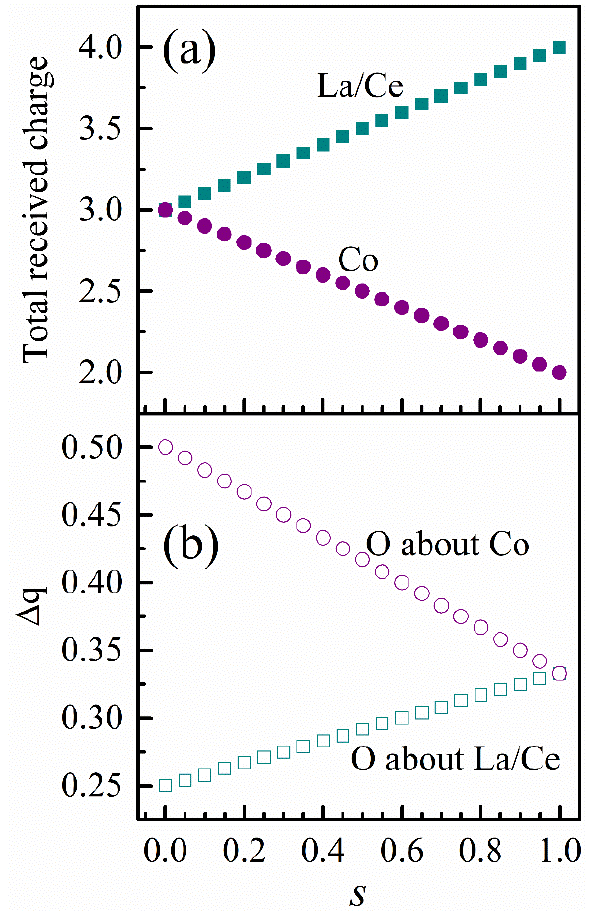
Figure 4. ( a ) Total charge received by La/Ce and Co and ( b ) fraction of charge ( △ q) received by each O-coordination about La/Ce and Co as a function of s , the fraction of cerium dopants in La 1 − s Ce s CoO 3 , which is the main phase of La 1 − x Ce x CoO 3 . The calculations use the structural param- eters obtained from the Rietveld refinement analysis, considering the main lattice as a cubic lattice. Figure 6 shows XANES data at the La L 3 -edge for La 1 − x Ce x CoO 3 . The spectrum of the pristine LCO reveals a sharp white line and two post-edge bulging features. These structures indicate holes in the La 5 d -band, O 2 p -La 5 d hybridization states, and possibly part of EXASF, respectively. It is clearly visible that the white line becomes enhanced with increasing Ce content, whereas the post-edge structure analogous to the bulge in the middle of the x = 0 spectrum takes a flat shape in the cases x = 0.2 and x = 0.4. These changes establish direct evidence that the La 5 d -band of the pristine LCO is in a partially filled state and eventually turns into a less occupied state when subject to the Ce addition. This finding on the occupancy of the La 5 d -band seems to be unexpected, because the La–O bond is commonly anticipated to be pure ionic, owing to a difference greater than 2.0 between the Pauling’s electronegativity of La (1.1) and that of O (3.44). There is, in fact, a differentiation of the La–O bond length in LCO; La–O bonds with short enough bond lengths have some covalent character, as is revealed in the discussion that